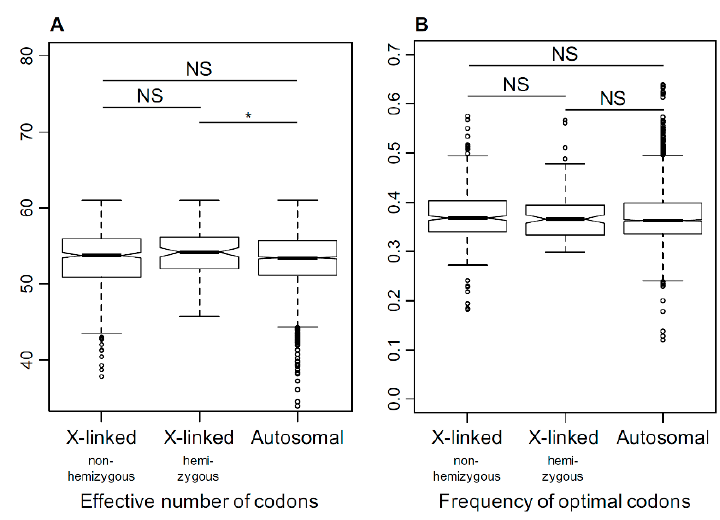
Figure 5. The comparison of codon bias in X-linked and autosomal genes, summarized as ( A ) effective number of codons (ENC) [60] and ( B ) frequency of optimal codons (FOP) [61]. All comparisons are non-significant (NS), except for the autosomal versus X-linked hemizygous genes for ENC, where the latter had marginally (Student’s test, * p = 0.0144) higher ENC (i.e., weaker codon